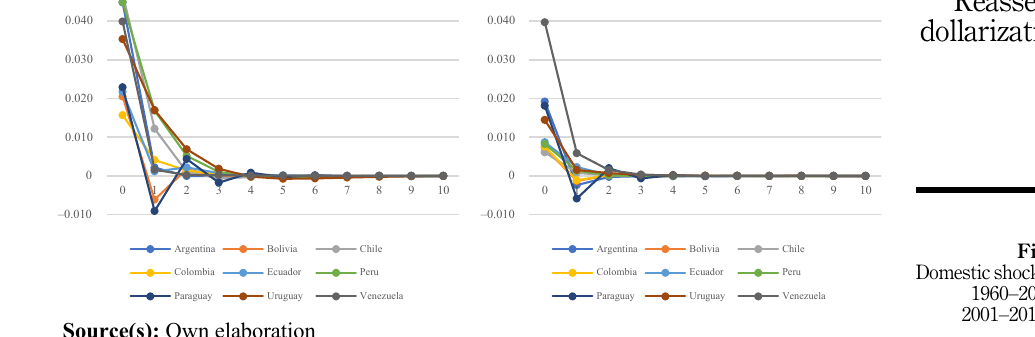
Figure 2. Domestic shocks in SA,